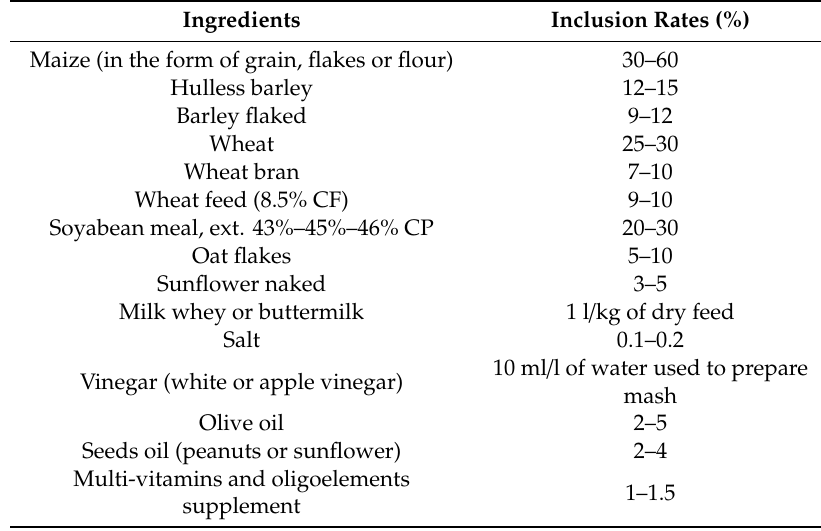
Table 1. Feeds used in diets and inclusion rates.